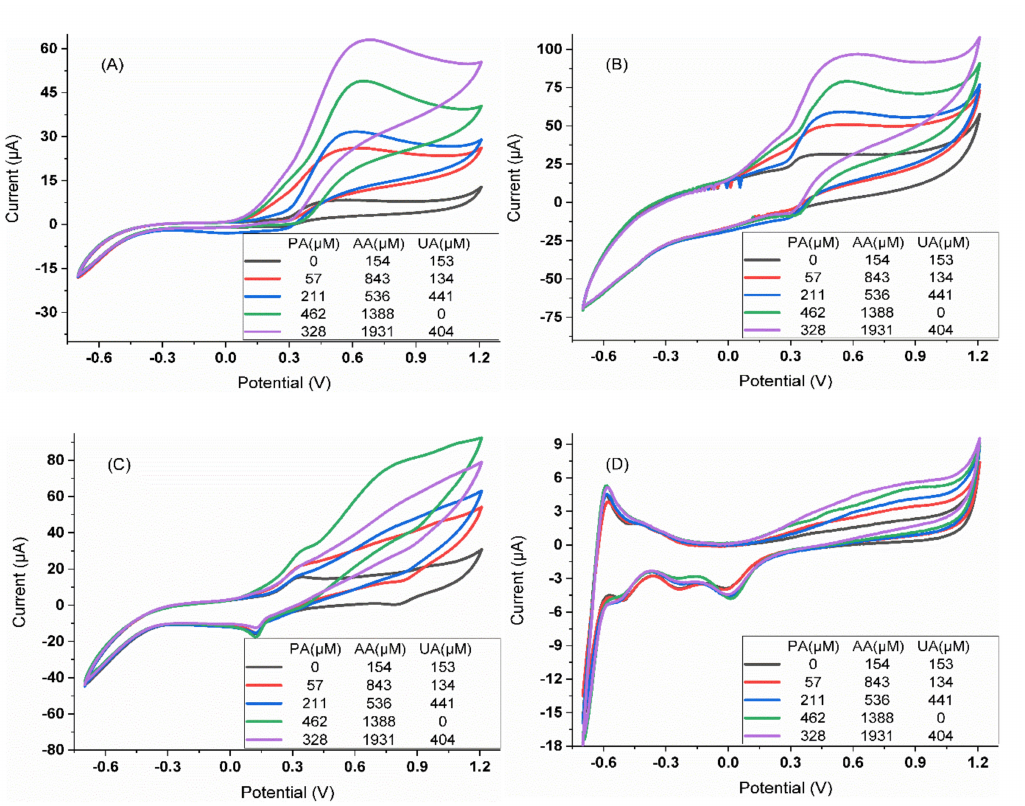
Figure 5. Representative voltammograms obtained for certain arbitrary mixtures of the di ff erent APIs (the concentration for each compound is indicated in the legend) with the four-sensor selected array: GECs modified with ( A ) ZnO, ( B ) PPy and ( C ) Prussian Blue, and ( D ) the metallic Pt electrode.